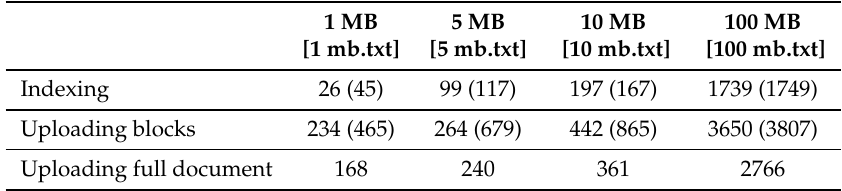
Table 2. Performance data for 5 blocks and (25 blocks) in